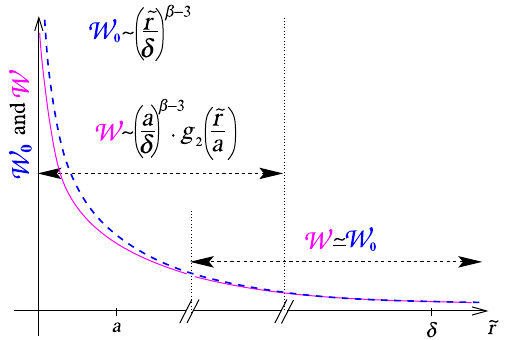
FIG. 5. Sketch of the (dimensionless) energy density profiles W W (e.g., solid line) as a function of the 0 (e.g., dotted line) and distance ~ r to the initial contact point. The dashed horizontal double arrows highlight two domains, corresponding to (i) ~ r ≫ a , where the (dimensionless) elastic energy densities W and W 0 are similar, and (ii) ~ r ≪ δ , where they are